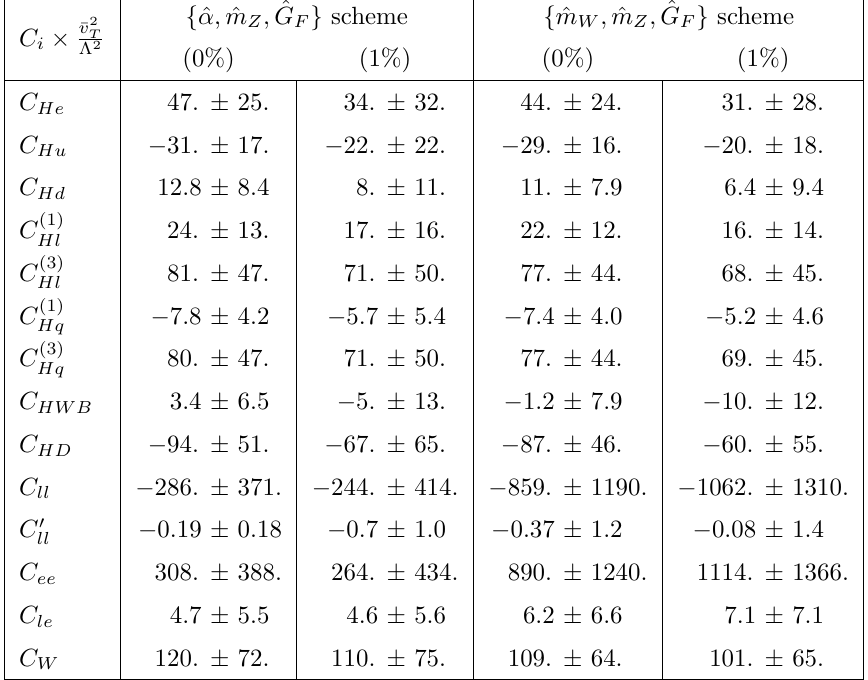
Table 5 . Best (cid:12)t values and corresponding 1 (cid:27) con(cid:12)dence regions for (cid:1) SMEFT = the two input parameter schemes considered in this work. The numbers have been obtaining after pro(cid:12)ling the (cid:31) 2 over the other parameters and they have been multiplied by a factor 100.